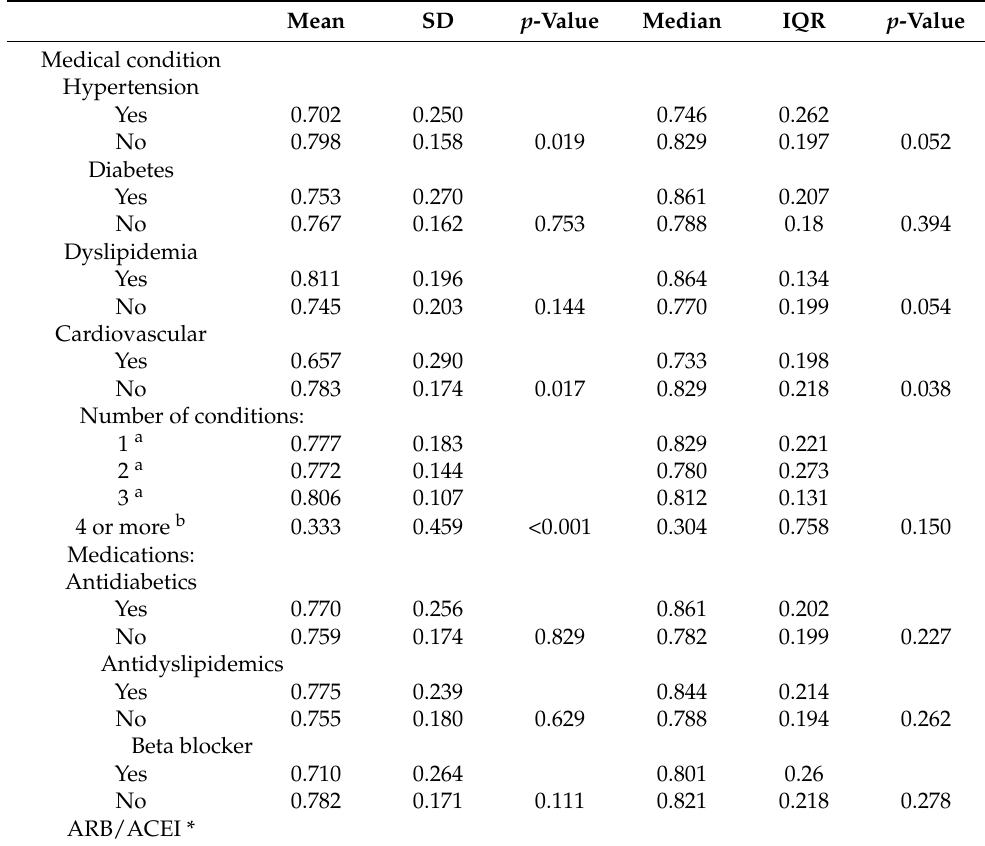
Table 5. EQ-5D-5L score by medical conditions and